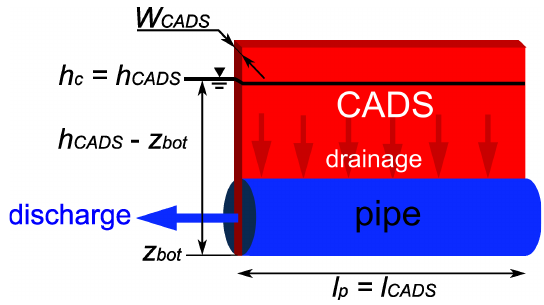
Fig. 3. Conceptual drawing of CADS consideration in